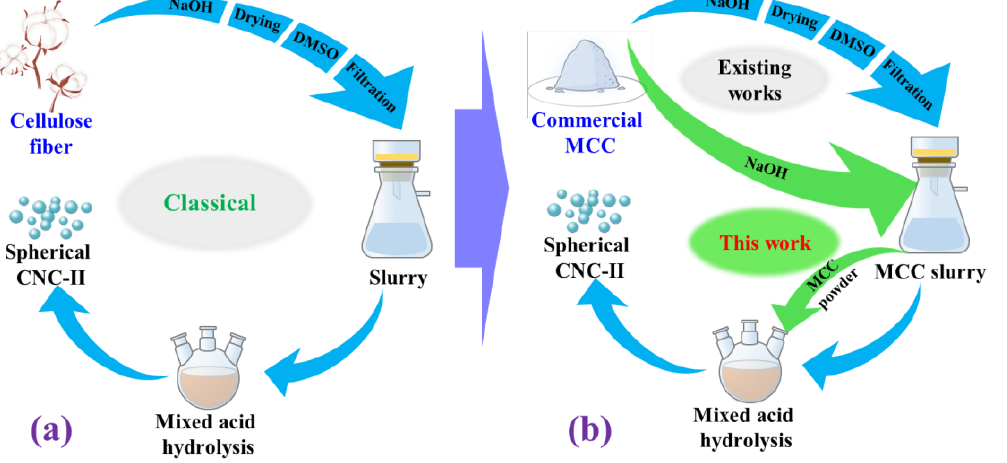
Figure 1. Schematic process flow of ( a ) spherical cellulose nanocrystal (CNC) preparation from cellulose fiber, and ( b ) spherical CNC preparation from commercial microcrystalline cellulose (MCC).